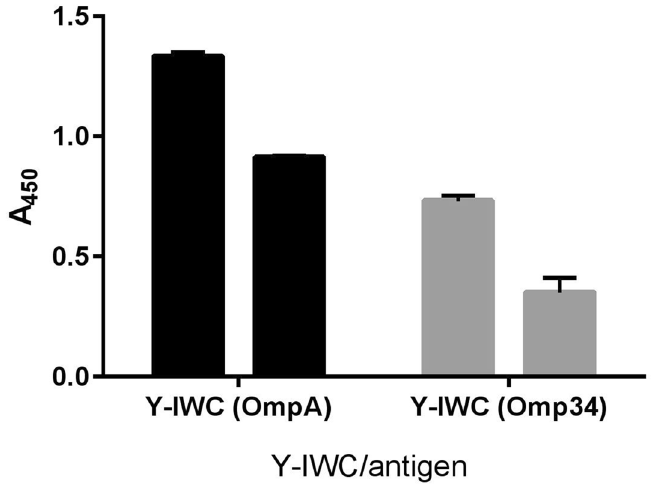
Figure 2. ELISA of rOmpA and rOmp34 antigens with IgY-IWC (Y-IWC). Two micrograms of antigens were coated. OmpA and Omp34 in parentheses show coated antigens. 5 and 2.5 µg of IgY-IWC was added to the wells. Y-IWC: IgYs raised against inactivated whole cell; the absorbance difference between rOmpA and rOmp34 antigens was significant using t-test ( P ≤ 0.01).